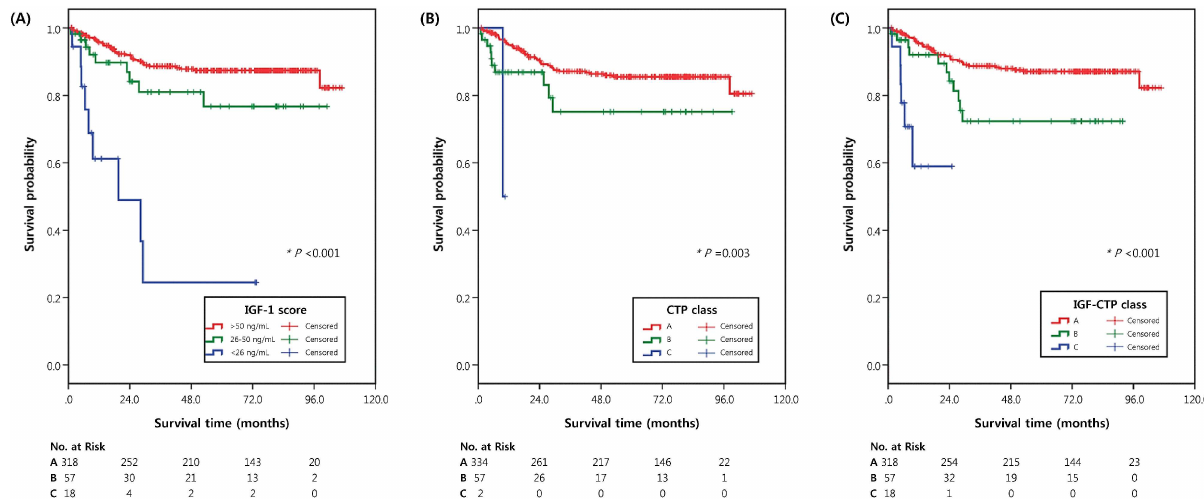
Fig 1. Kaplan-Meier survival curves of patients classified by serum levels of IGF-1 (A), CTP class (B), and IGF-CTP class (C). Tables beloweach graph show the numbers of patients at risk at varioustime points.